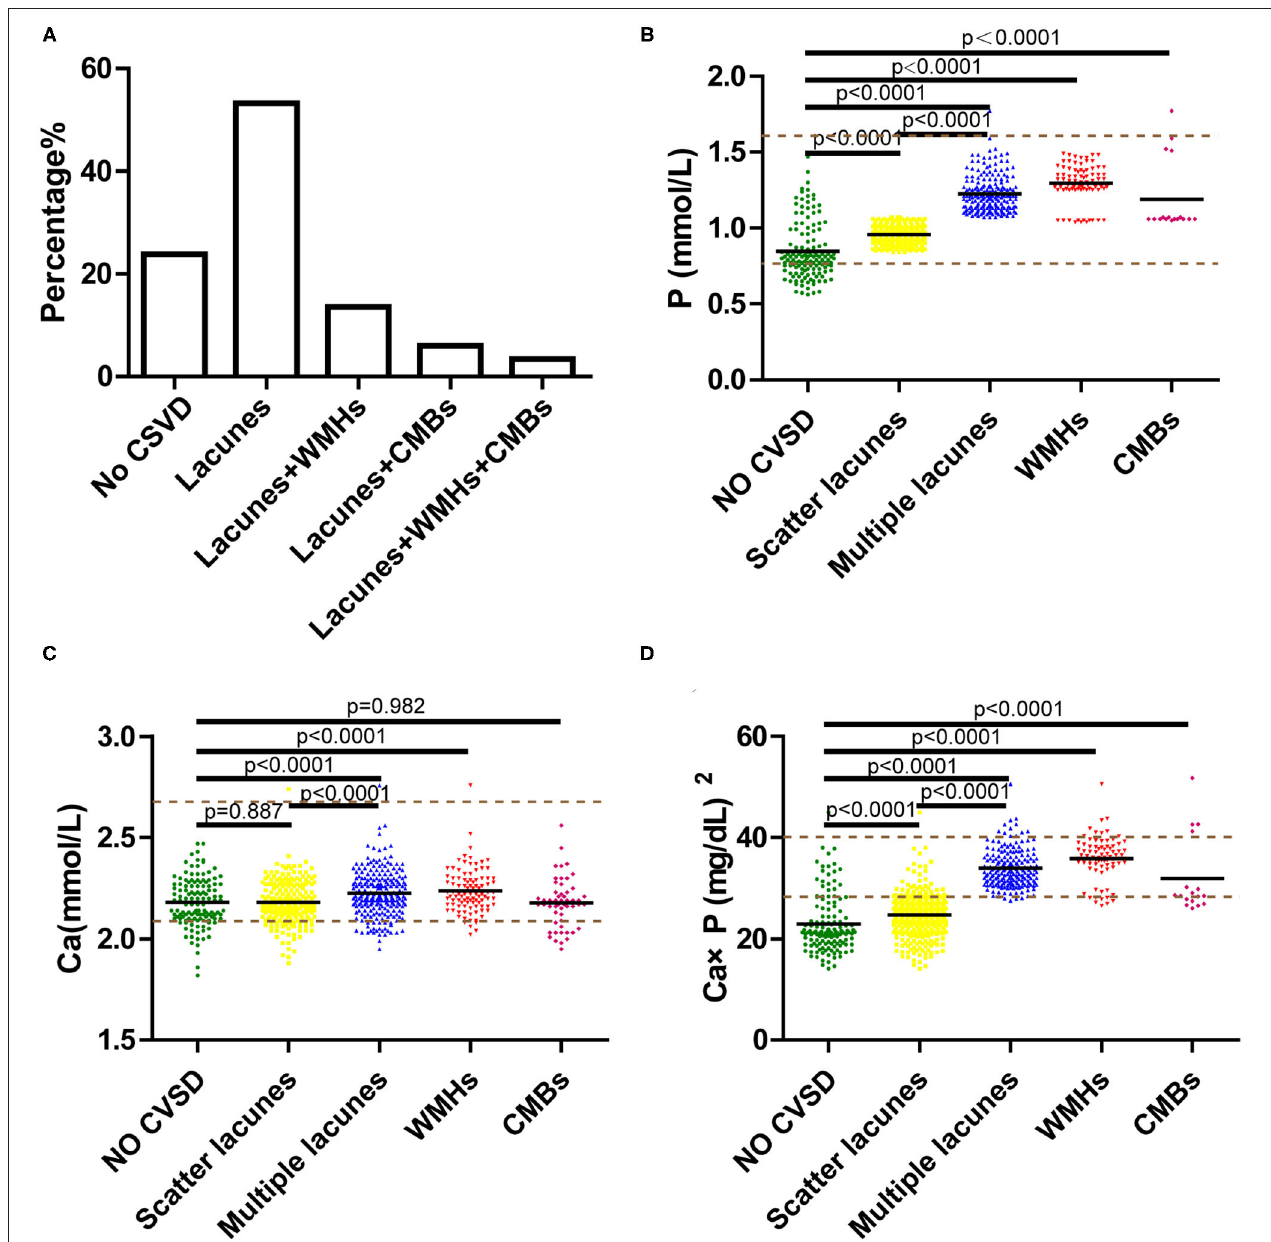
FIGURE 3 | (A) Percentage of single or combined subtypes in cerebral small vessel disease (CSVD). (B–D) Serum phosphorus (P), calcium (Ca), calcium-phosphate product (Ca × P) of subtypes in CSVD, including scattered lacunes, multiple lacunes, white matter hyperintensities (WMHs), and cerebral microbleeds (CMBs). Brown dotted lines are the upper and lower limits of normal